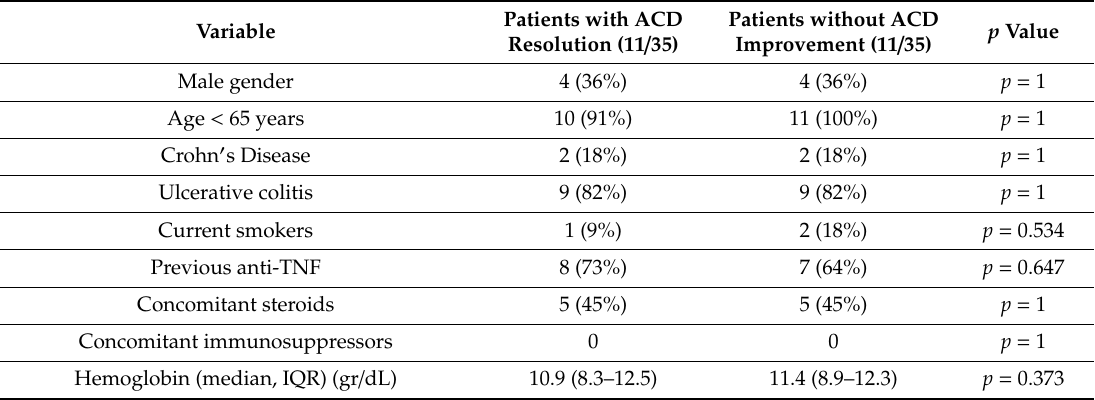
Table 3. Distribution of baseline demographic / clinical characteristics and clinical responses to Vedolizumab in patients with ACD resolution, as compared to patients without ACD improvement. Patients with Variable